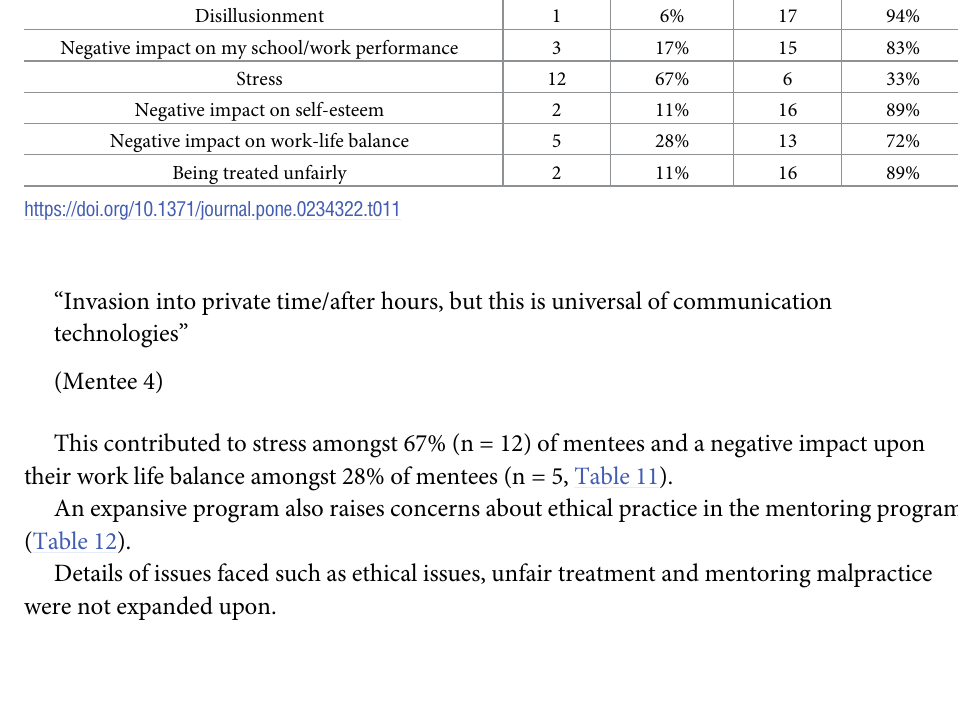
Table 11. Challenges faced as part of mentoring program. I faced the following challenges in the context of the mentoring program: